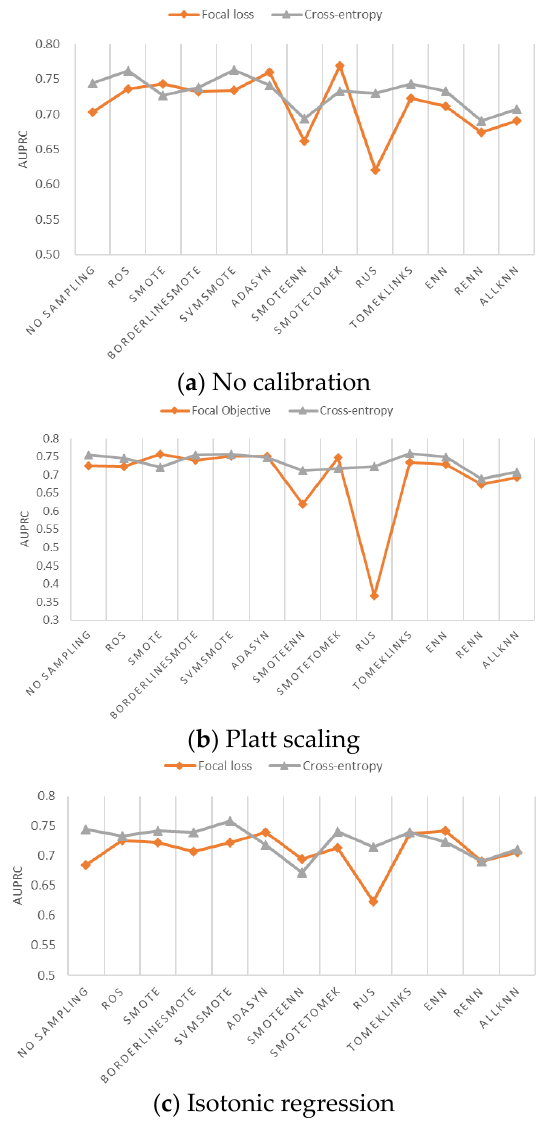
Figure 7. AUPRC of XGBoost with weighted focal loss and weighted cross-entropy